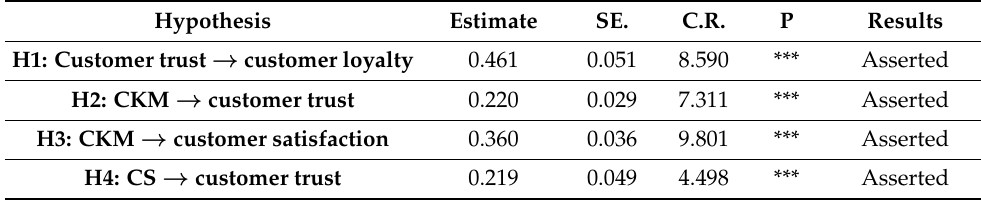
Table 7. Structural model